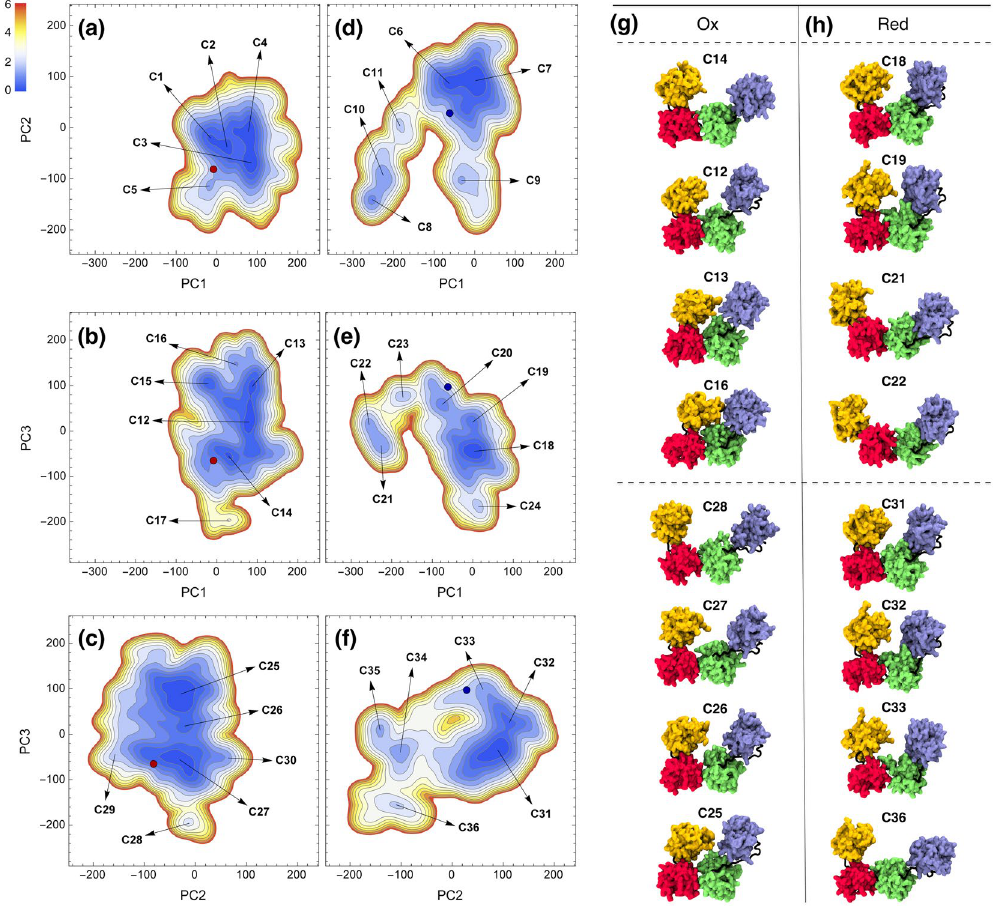
Figure 4. Projections of free energy landscape on two-dimensional spaces spanned by PC1-PC2, PC1-PC3 and PC2-PC3 in oxidized ( a , b and c ) and reduced ( d , e and f ) conformations. Conformers are numbered from C1 to C36. Representative conformers of FEL minima in oxidized ( g ) and reduced ( h ) states of hPDI. Yellow, red, green and blue stand for a, b, b’ and a’ domains,